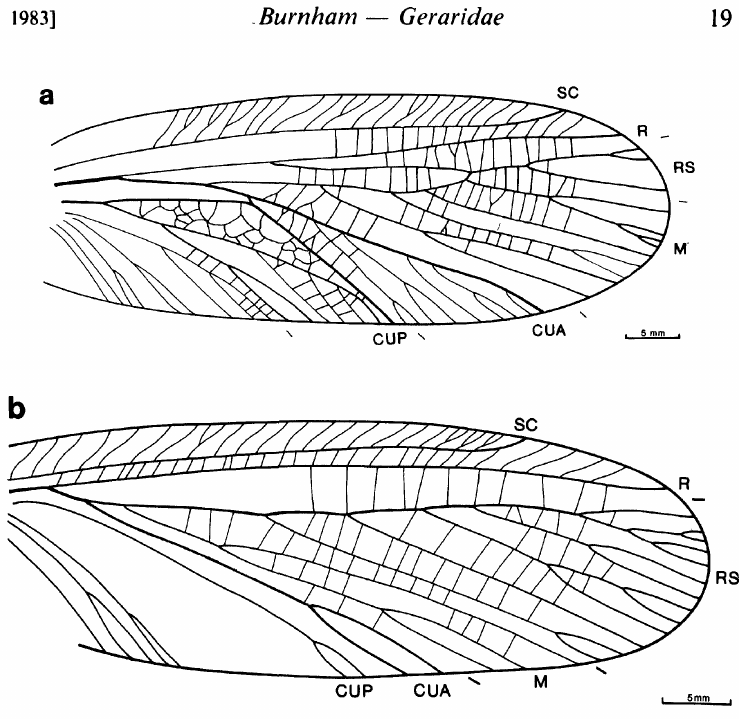
Fig. 6. Gerarus danielsi, a. composite drawing of the fore wing, based primarily on FMNH PE 5276, 31973; and DMRW I. b. composite drawing of the hind wing, based primarily on USNM 35574, FMNH PE 32031, and MCZ 222.